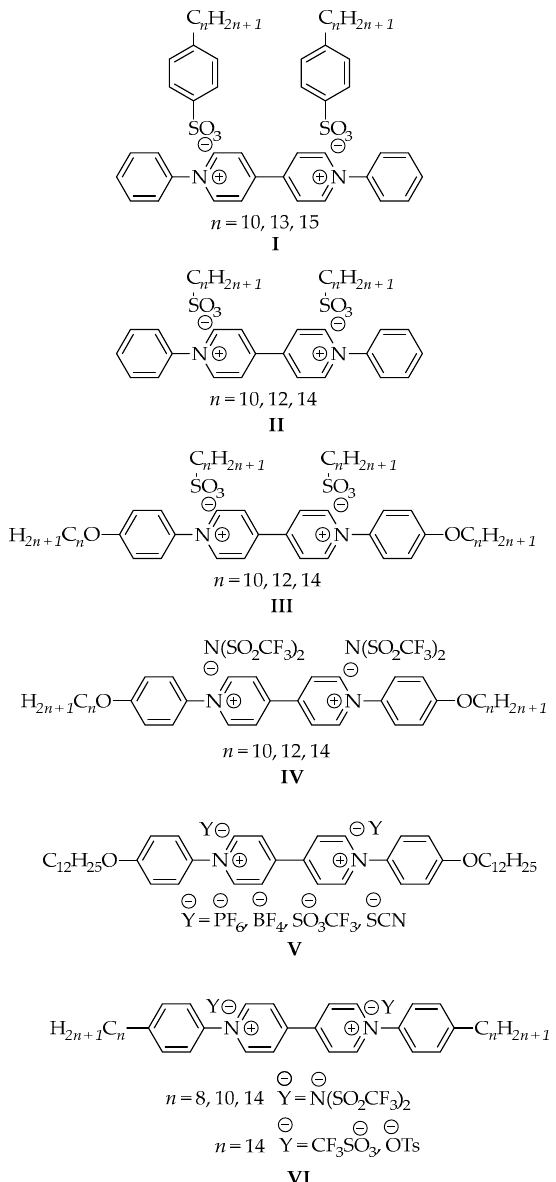
Figure 1. Chemical structures of extended viologen salts that exhibit smectic A (SmA) phases.